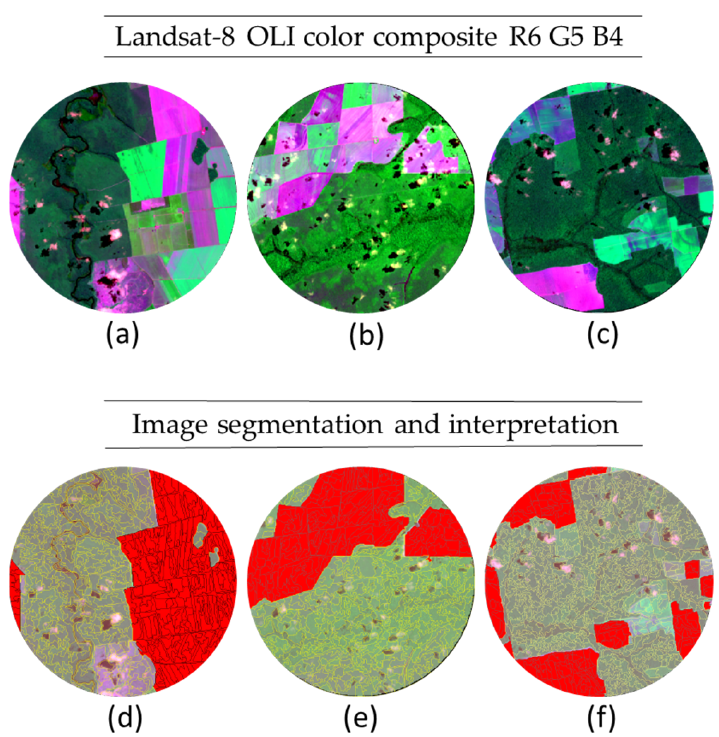
Figure 10. Examples of Landsat-8 OLI color composite ( a – c ) and corresponding image segmentation and interpretation ( d – f ) in the municipalities of Sapezal/Campos de Júlio, Brasnorte, and Nova Mutum, respectively. Yellow lines represent the segments while red polygons represent the annual croplands.